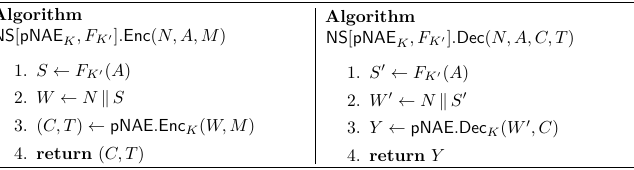
Figure 7: Generalized Nonce